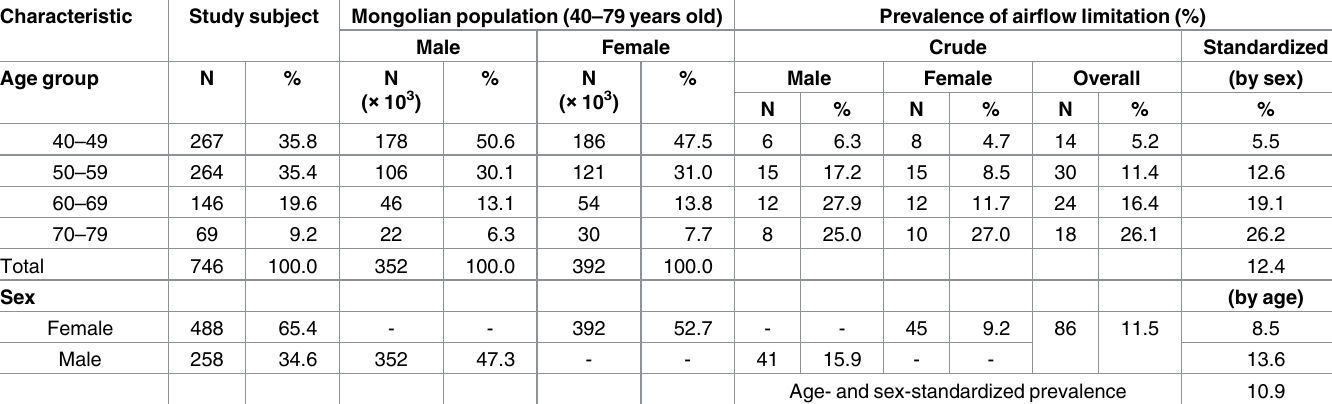
Table 2. Prevalence of airflow limitation in study population standardized by Mongolian population.